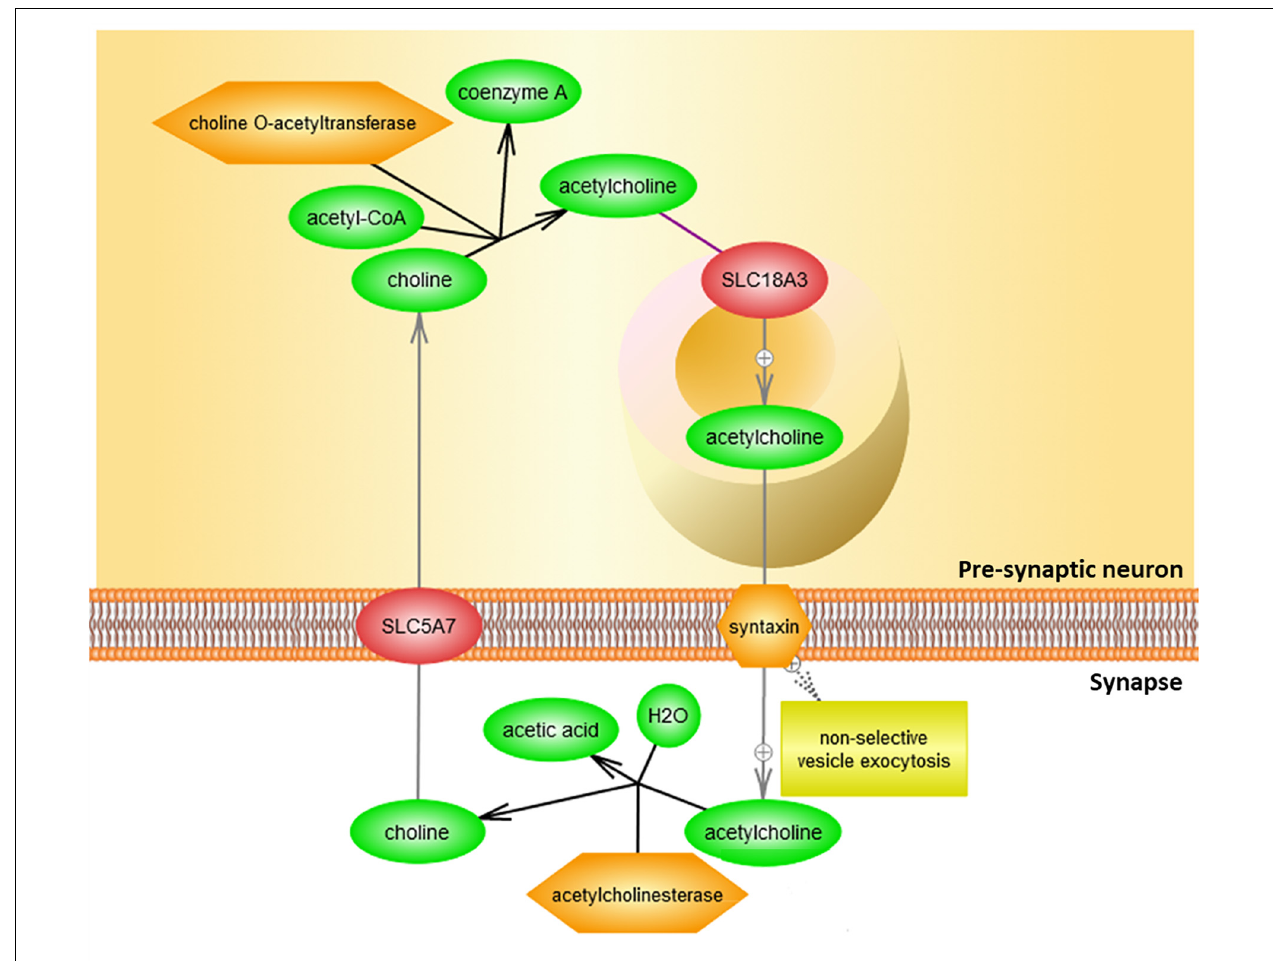
FIGURE 4 | Clearance of acetylcholine from the synapse by acetylcholinesterase. Acetylcholine (ACh) is delivered to the synapse as a result of vesicle exocytosis from pre-synaptic neuronal signaling and a release of the recycled acetylcholine from the postsynaptic neuron’s cholinergic receptors. In the synaptic cleft, acetylcholinesterase (ACHE) then degrades acetylcholine. Resulting choline is then taken back by the presynaptic neuron to be recycled in order to make more acetylcholine for future signaling. This figure was extracted from Pathway Studio’s curated pathways and was edited according to the needs of this